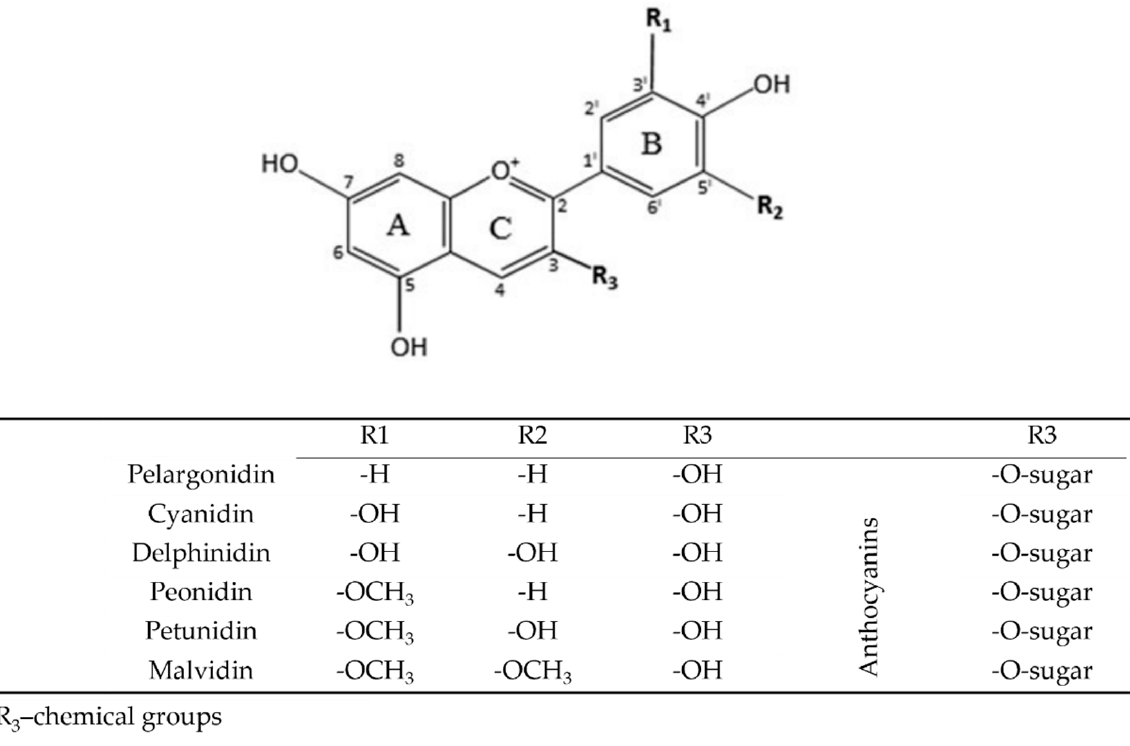
Figure 1. Chemical structure of the main anthocyanidins and anthocyanins present in plant food; based on [16,24,25].